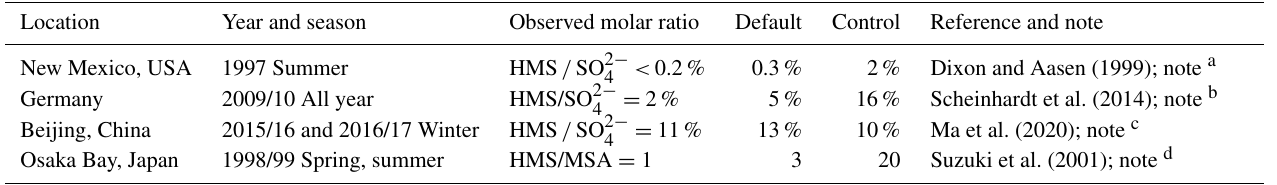
Table 5. Comparison between observations and model simulations.